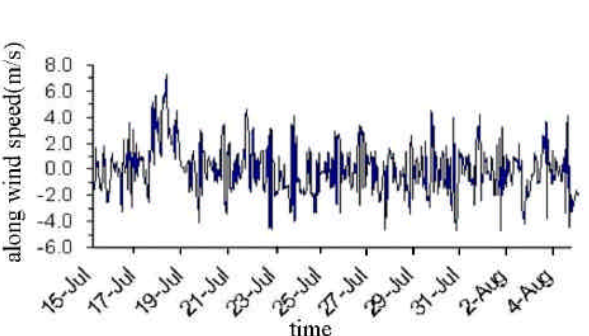
Figure4. Hourly time series of onshore wind against time (24h interval)